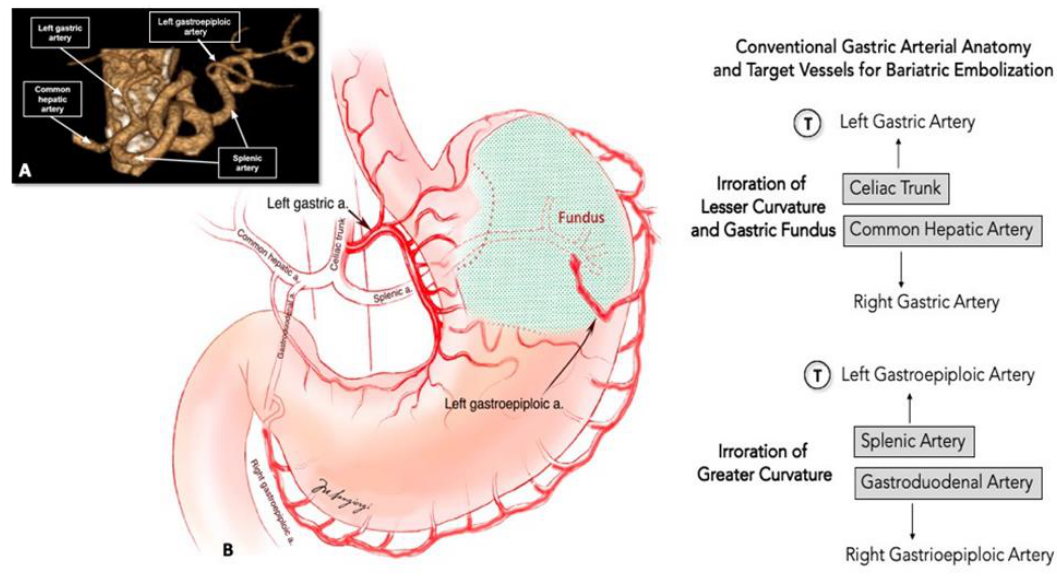
Figure 3. Voxel Gradient Angio-CT 3D reconstruction ( A ) and schematic drawn ( B ) of left gastric artery and left gastroepiploic artery normal anatomy. Most commonly the left gastric artery originates from the celiac trunk. Less frequently, the artery may arise directly from the aorta, splenic artery, common hepatic artery, and superior mesenteric artery. The superior part of the greater curvature of the stomach is supplied by the left gastroepiploic artery while the inferior part of the greater curvature by the right gastroepiploic artery. T indicates target for BES procedure.